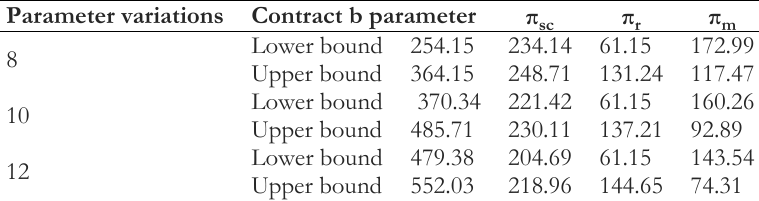
Table 10. The trend of variations in firms' profits due to variations in production costs post-contract.